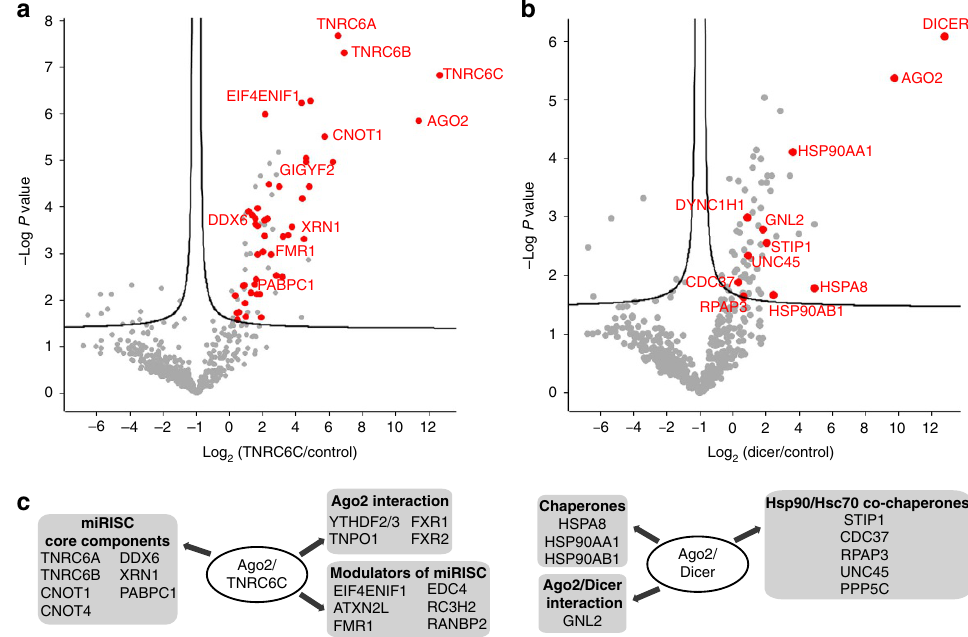
Figure 7 | Main hits enriched in Ago2/Dicer and Ago2/TNRC6C split-BioID. Volcano plot showing proteins enriched in the TNRC6C ( a ) or Dicer ( b ) sample over the control BioID samples as in Fig. 3c. Hits that showed higher LFQs than in the GFP and the Dicer samples ( a ) or in the GFP and TNRC6C samples ( b ) are indicated in red. For clarity, not all hits are labelled ( c ) Selected hits from the MS analysis of Ago2/Dicer (right) anf Ago2/TNRC6C (left) split-BioID samples. The complete list is given in Supplementary Data